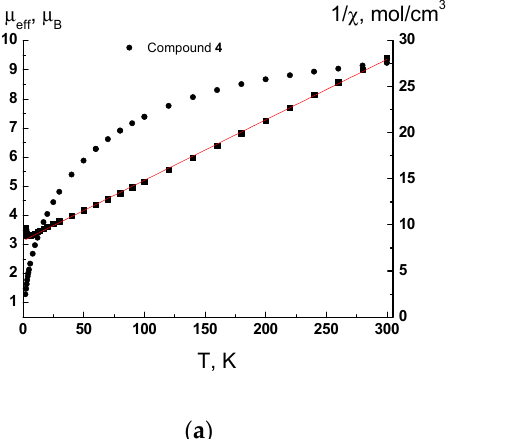
Figure 5. Temperature dependencies of the µ eff ( ○ ) and 1 / χ ( ■ ) for complex 1 . Solid line is a theoretical curve.